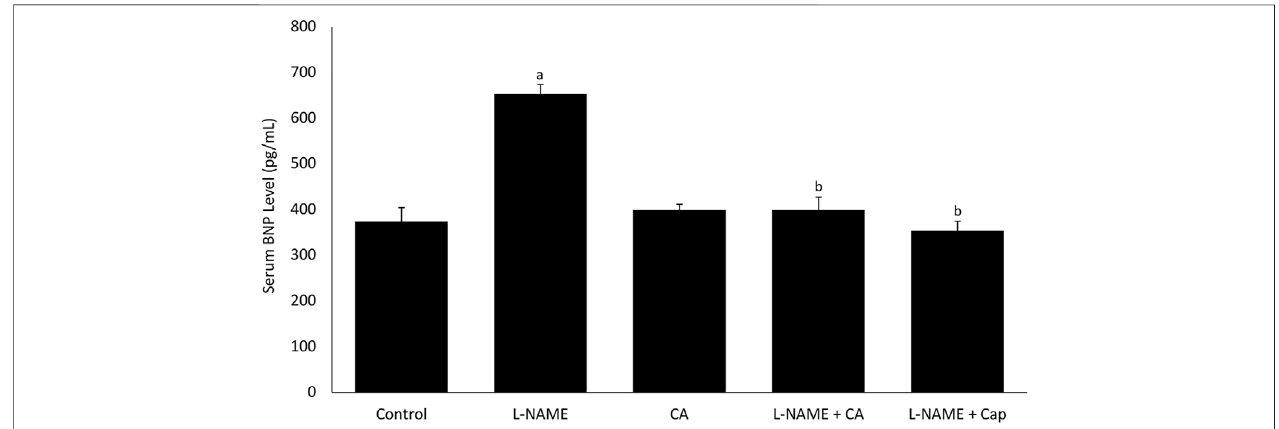
FIGURE6| SerumB-natriureticpeptide(BNP)levelinratsco-treatedwith L -NAME(40 mg/kgorally)and C.asiatica extract(500 mg/kgorally)orcaptopril(5 mg/kg orally) for 8 weeks. Bars represent mean ± SEM ( n (cid:1) 6). a versus control ( p < 0.05), b versus L -NAME ( p < 0.05).